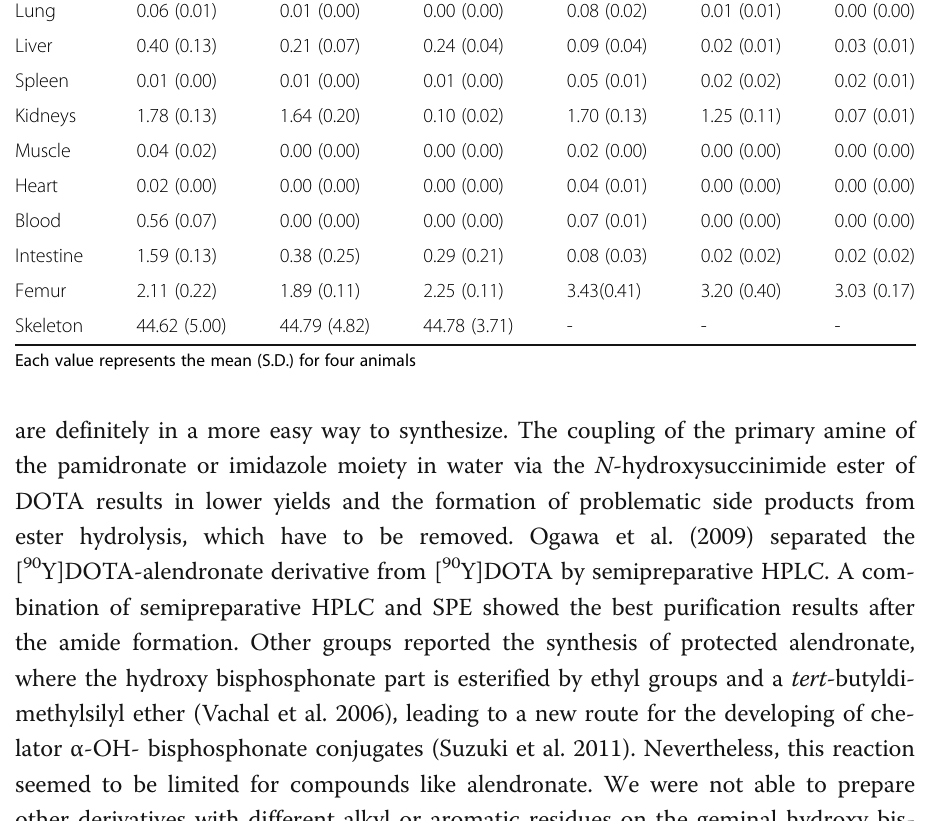
Table 3 Ex vivo biodistribution of [ 177 Lu]DOTA ZOL in healthy Wistar rats after 1 h, 1 and 8 days p.i. , expressed in terms of %ID per organ and per gram tissue, respectively Organ % ID per Organ % ID per gram